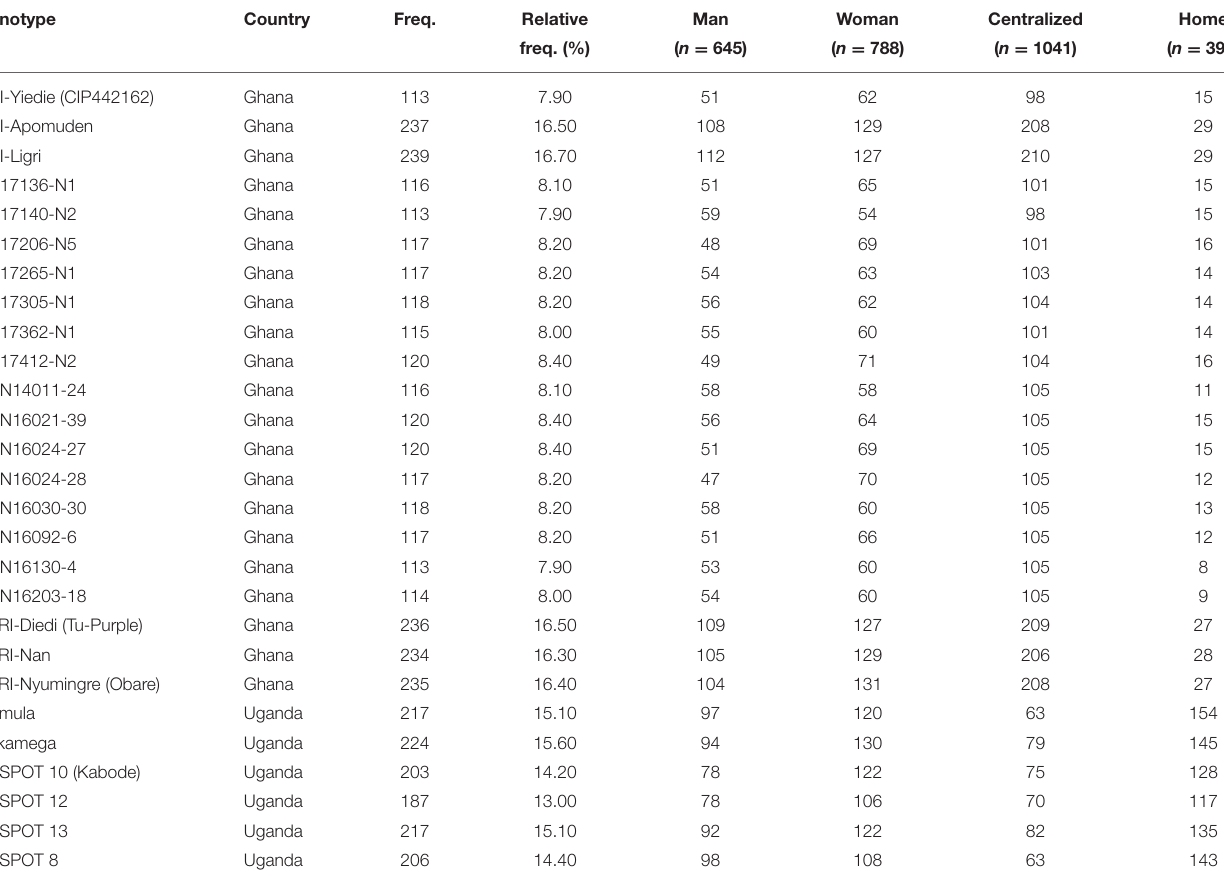
TABLE 3 | Frequency of genotypes assessed in this study. Genotype